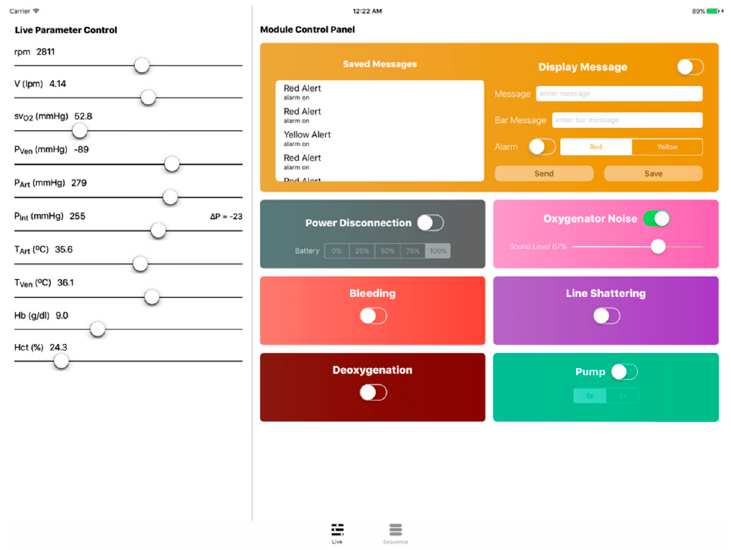
Figure 9. The instructor app including the live control panel view.